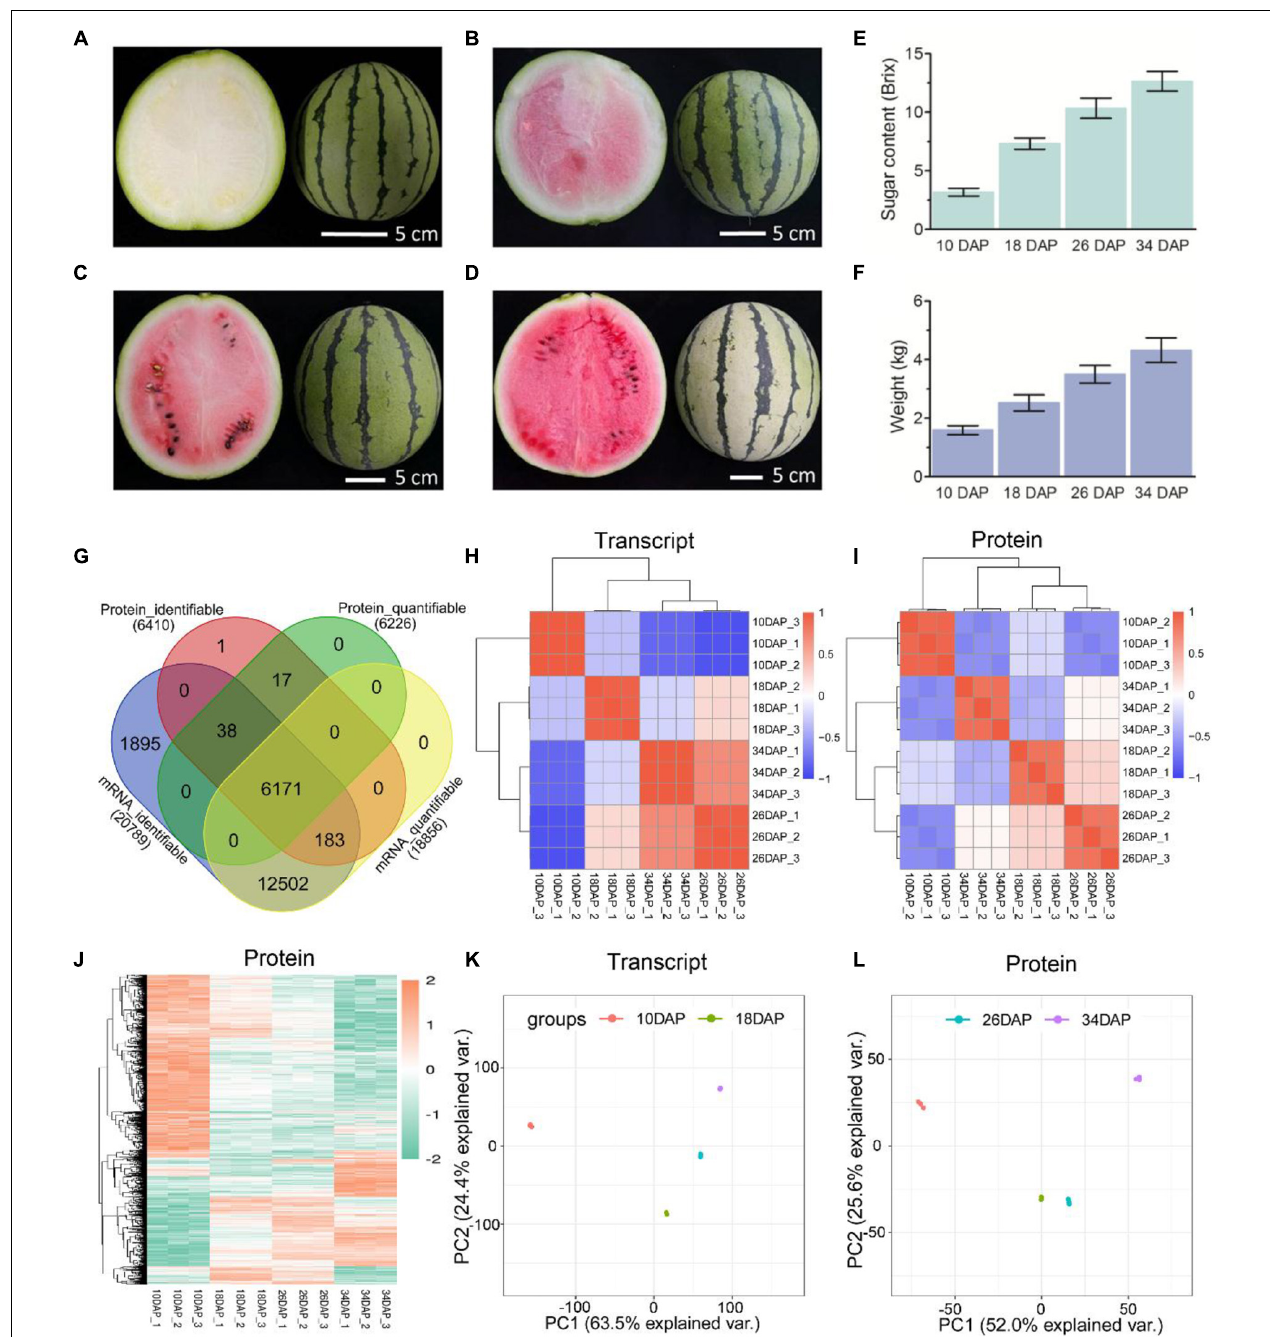
FIGURE 1 | Overview and reproducibility of the proteome and transcriptome. Fruits of the cultivated watermelon 97103 at four different stages of ripening. (A) White [10 days after pollination (10 DAP)], (B) white-pink (18 DAP), (C) red flesh (26 DAP), (D) red-ripe (34 DAP). Sugar content of center flesh (E) and weight (F) statistics of four stages. (G) Venn diagram of identifiable and quantifiable mRNAs and proteins in this study. Heatmaps of Pearson correlation values of the TMT-labeled protein (I) and mRNA (H) abundances of each of the replicates compared to every other replicate. (J) Hierarchical clustering analysis of differentially expressed proteins (DEPs). Principal component analysis (PCA) was used to evaluate the reproducibility of the samples from proteome (L) and transcriptome (K) .